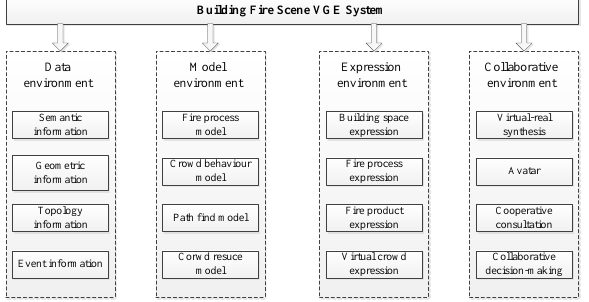
Figure 2. Framework of building fire scene VGE